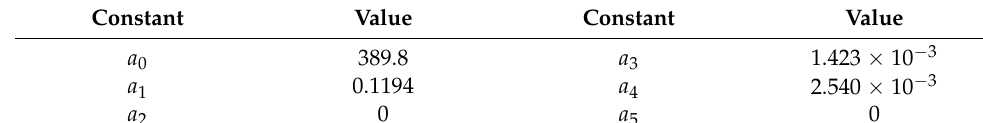
Table 1. Polynomial trend constants.